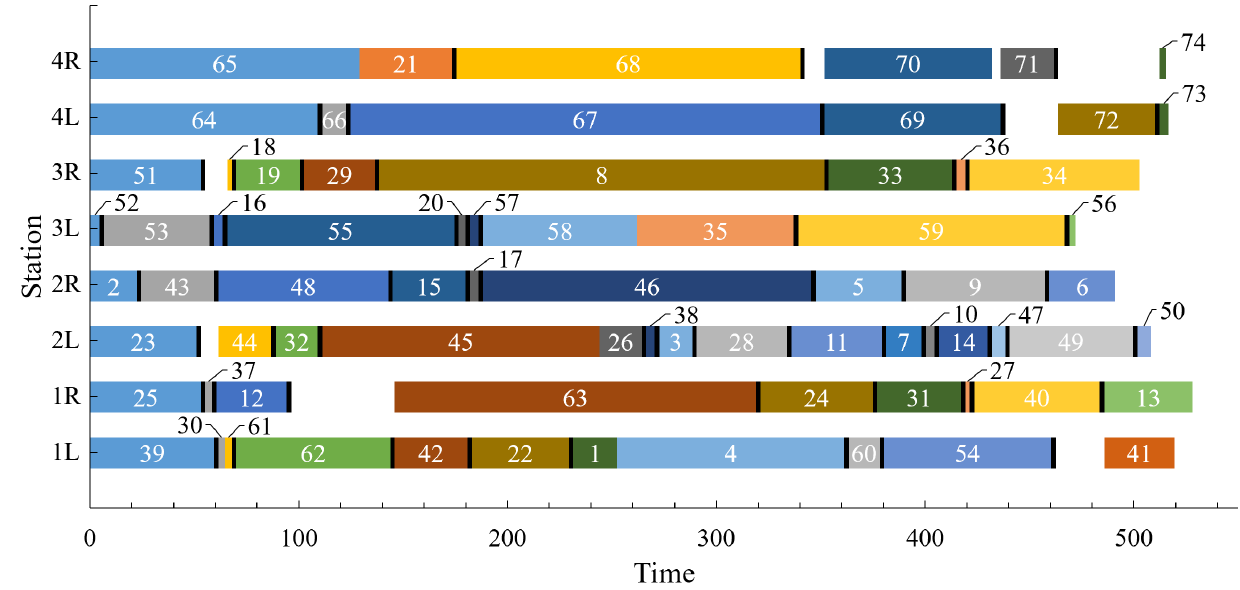
Figure 8. Gantt chart of disassembly scheme S 2 .